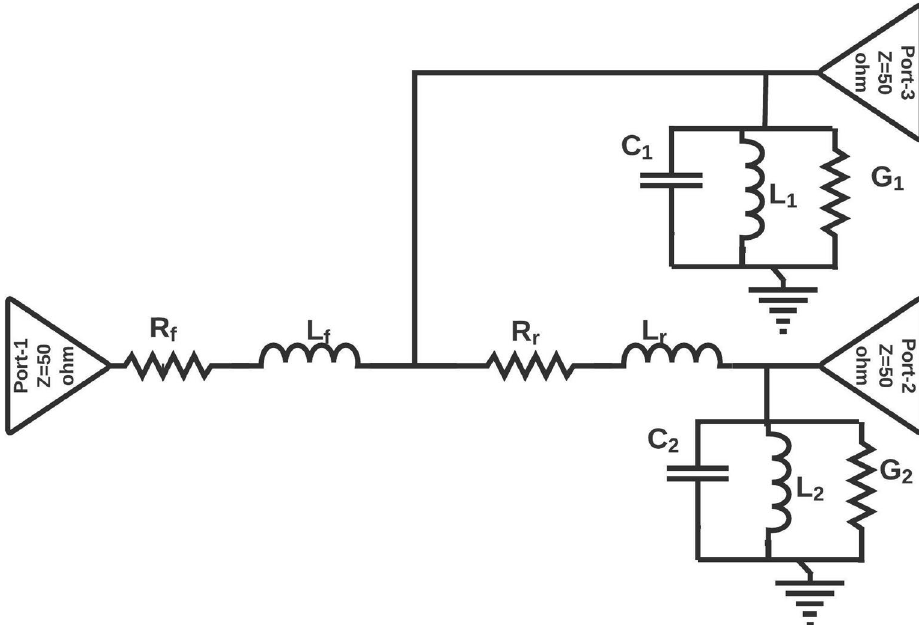
Figure 3. Equivalent circuit model of Narrow band antennas (NB).